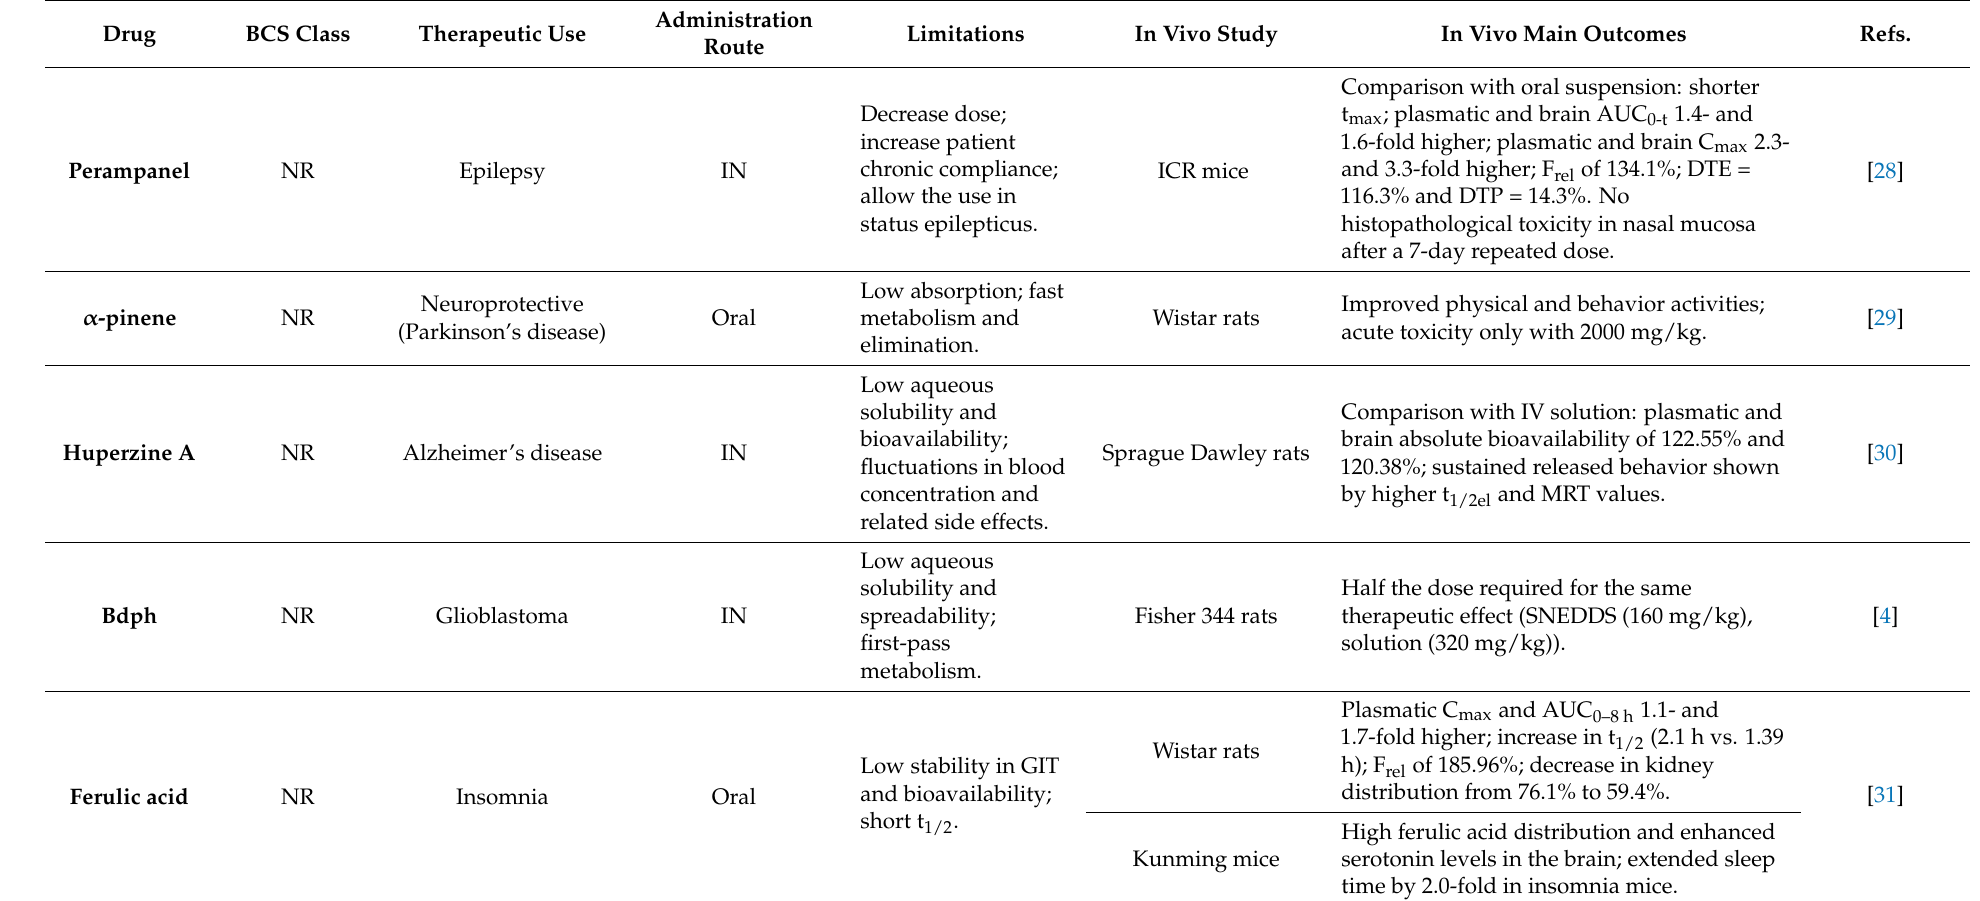
Table 2. Pre-clinical studies for evaluation of in vivo outcomes after administration of neurotherapeutics loaded in self-emulsifying drug delivery systems (SEDDS). The methodology used for data collection is summarized in Figure S1 of the Supplementary